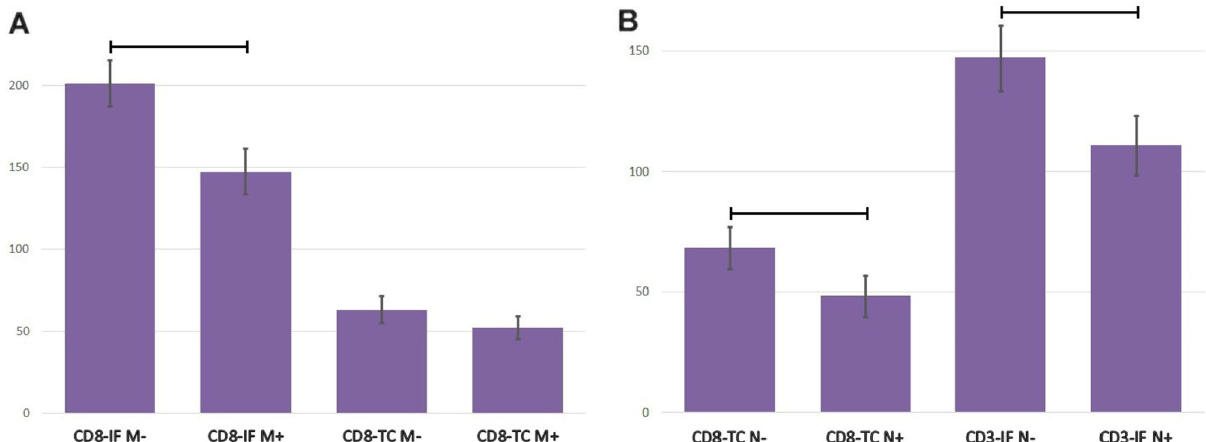
Figure 3. ( A ) The densities of tumor-infiltrating lymphocytes CD8 in invasive front and tumor-associated neutrophils in tumor center in colorectal cancer tissue of patients with distant (M+) and no metastases (M−). Data are presented as means and standard errors. Horizontal lines indicate significant differences at p < 0.05. ( B ) The densities of tumor-infiltrating lymphocytes CD8 in tumor center and CD3 in invasive front in colorectal cancer tissue with (N+) and without (N−) metastases to the surrounding lymph nodes. Data are presented as means and standard errors. Horizontal lines indicate significant differences at p <